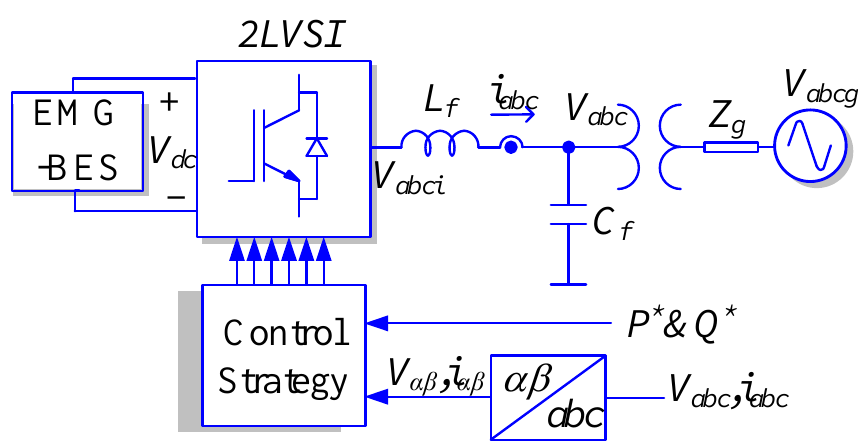
Figure 4. Overall schematic of the proposed bioelectrochemical power to gas station.